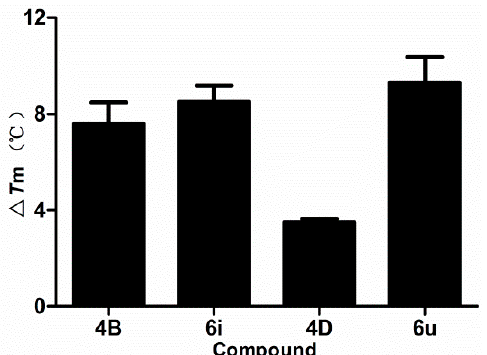
Figure 6. Thermal denaturation study of the complexes of β -carbolines ( 4B , 6i , 4D , and 6u ) and CT-DNA. Melting temperatures were measured in PBS-EDTA buffer (1 mM Na 2 HPO 4 , 0.1 mM EDTA, PH 7.4) with a β -carboline ( 4B , 6i , 4D , and 6u )/DNA ratio of 0.5. Δ T m = ( Δ T m 4B , 6i , 4D , or 6u + DNA − Δ T mDNA ).